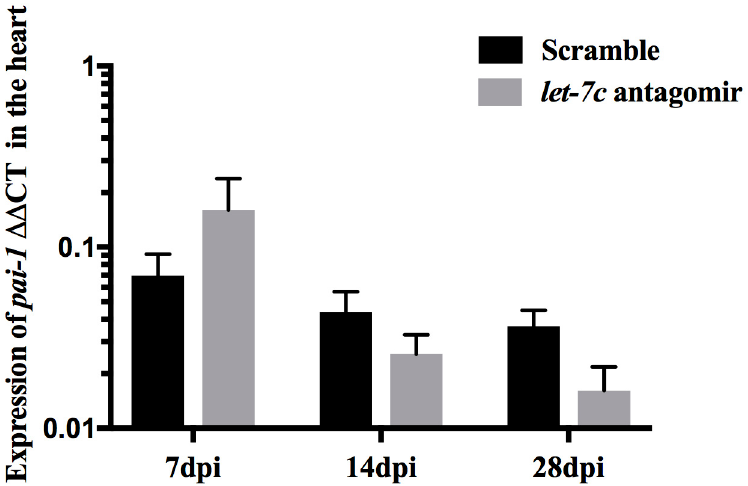
Figure 3. pai-1 expression in the heart quantified by qPCR at 7 dpi, 14 dpi and 28 dpi. The internal control gene rps3 used for normalizing the expression levels by the ∆∆ CT method. ( n = 6 for 7 dpi antagomir and scramble, n = 5 for 14 dpi antagomir and scramble, n = 4 for 28 dpi antagomir and n = 5 for 28 dpi scramble).